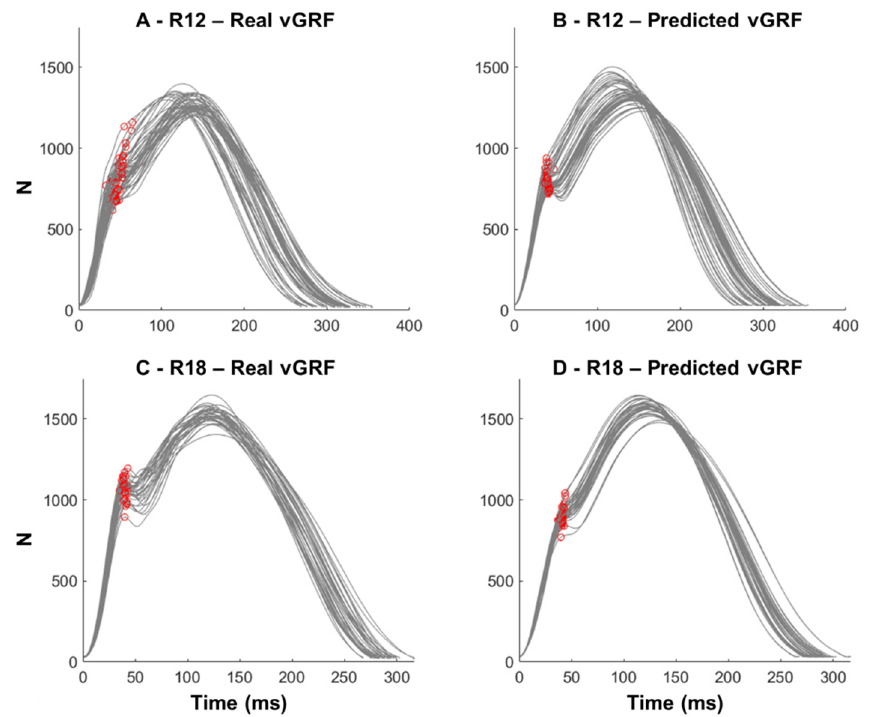
Figure 2. Illustrative examples from two runners (Runner 12 in plots A and B ; Runner 18 in plots C and D ) of the identification of impact peak instants from real and predicted vertical ground reaction forces (vGRF, in Newton (N)) in runners not presenting prominent impact peak. The red circles identify the transition point where the vGRF curve presents a deflection.